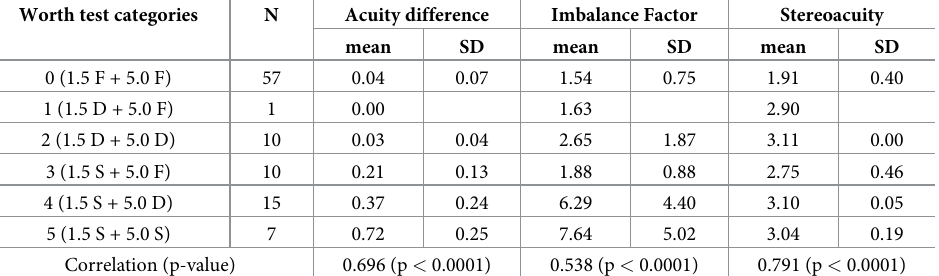
Table 1. Correlation between Worth 4 dot test and triplet variables. Mean and Standard Deviation for each variable of the triplet (interocular visual acuity difference, stereoacuity and imbalance factor) for each category considered of Worth test. Worth test answers have been ordered according to the extent of suppression scotoma, considering diplo- pia as an intermediate stage between fusion and suppression. Number of occurrences in the sample, N, is also included. Correlations and p-values between Worth test categories and each variable of the triplet are included in the last